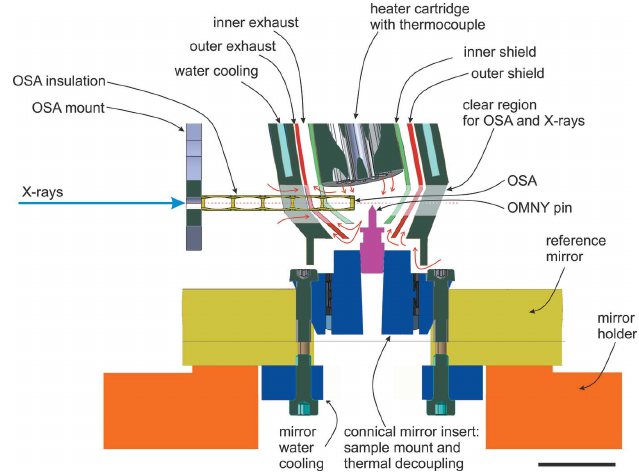
Figure 3 Vertical cut, along the X-ray propagation direction, through the setup at the sample plane. The red arrows in the nozzle region indicate the gas flow directions. Scale bar: 10